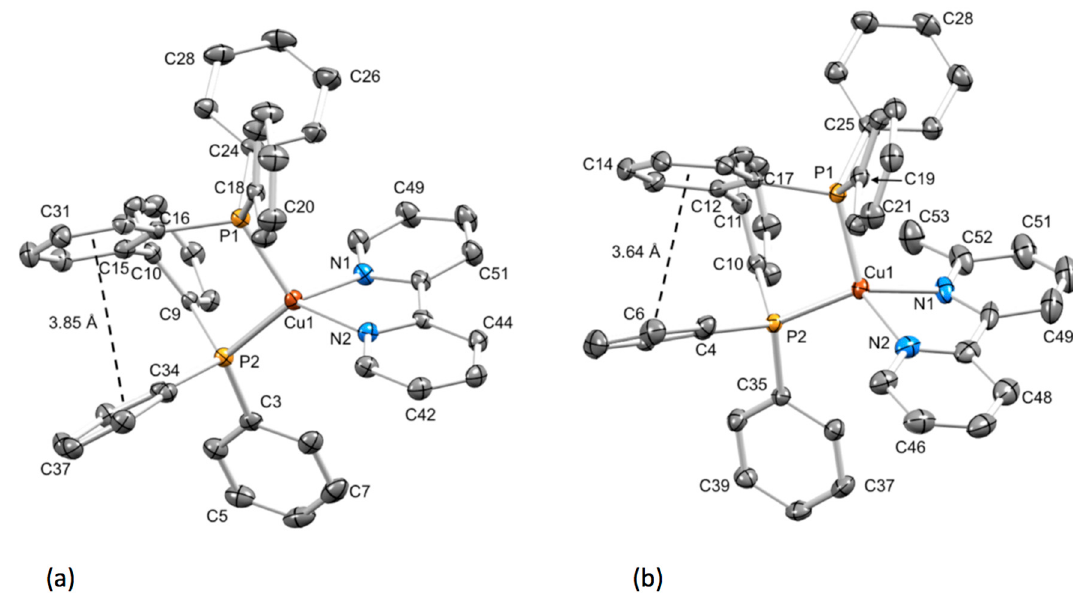
Figure 5. Structures of ( a ) the [Cu(BIPHEP)(bpy)] + cation in [Cu(BIPHEP)(bpy)][PF 6 ] ∙ CH 2 Cl 2 and ( b ) the [Cu(BIPHEP)(6-Mebpy)] + cation in [Cu(BIPHEP)(6-Mebpy)][PF 6 ] ∙ Et 2 O ∙ 0.5H 2 O. Ellipsoids are plotted at 50% probability in ( a ) and 40% in ( b ); H atoms are omitted for clarity. Each cation exhibits π -stacking between two phenyl rings in BIPHEP backbone. In ( a ) the angle between the ring planes = 25.7°, centroid...centroid distance = 3.85 Å, and in ( b ) the angle between the ring planes = 15.1°, centroid...centroid distance = 3.64 Å.